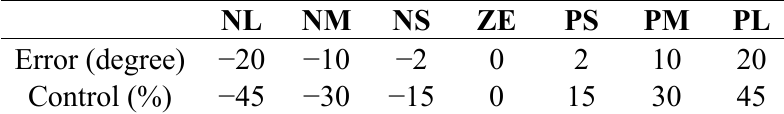
Table 4. Roll Rule Inference.